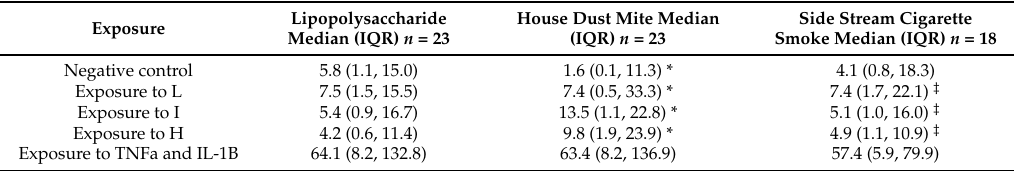
Table 1. Median and interquartile range (IQR) concentrations of interleukin (IL)-6 in supernatants